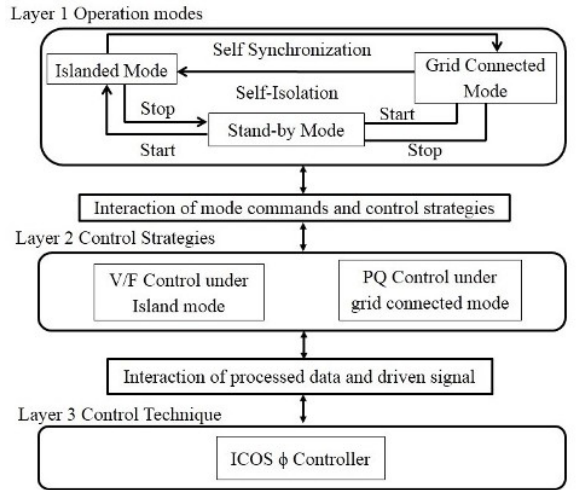
Fig. 2. Three layer hierarchical control